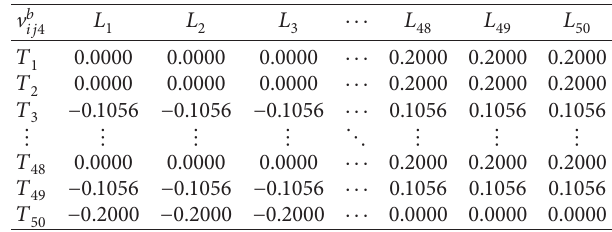
Table 32: Perceived utility matrix V b ′ � [ d ij ′ ] for 4 4 50 × 50 living room.